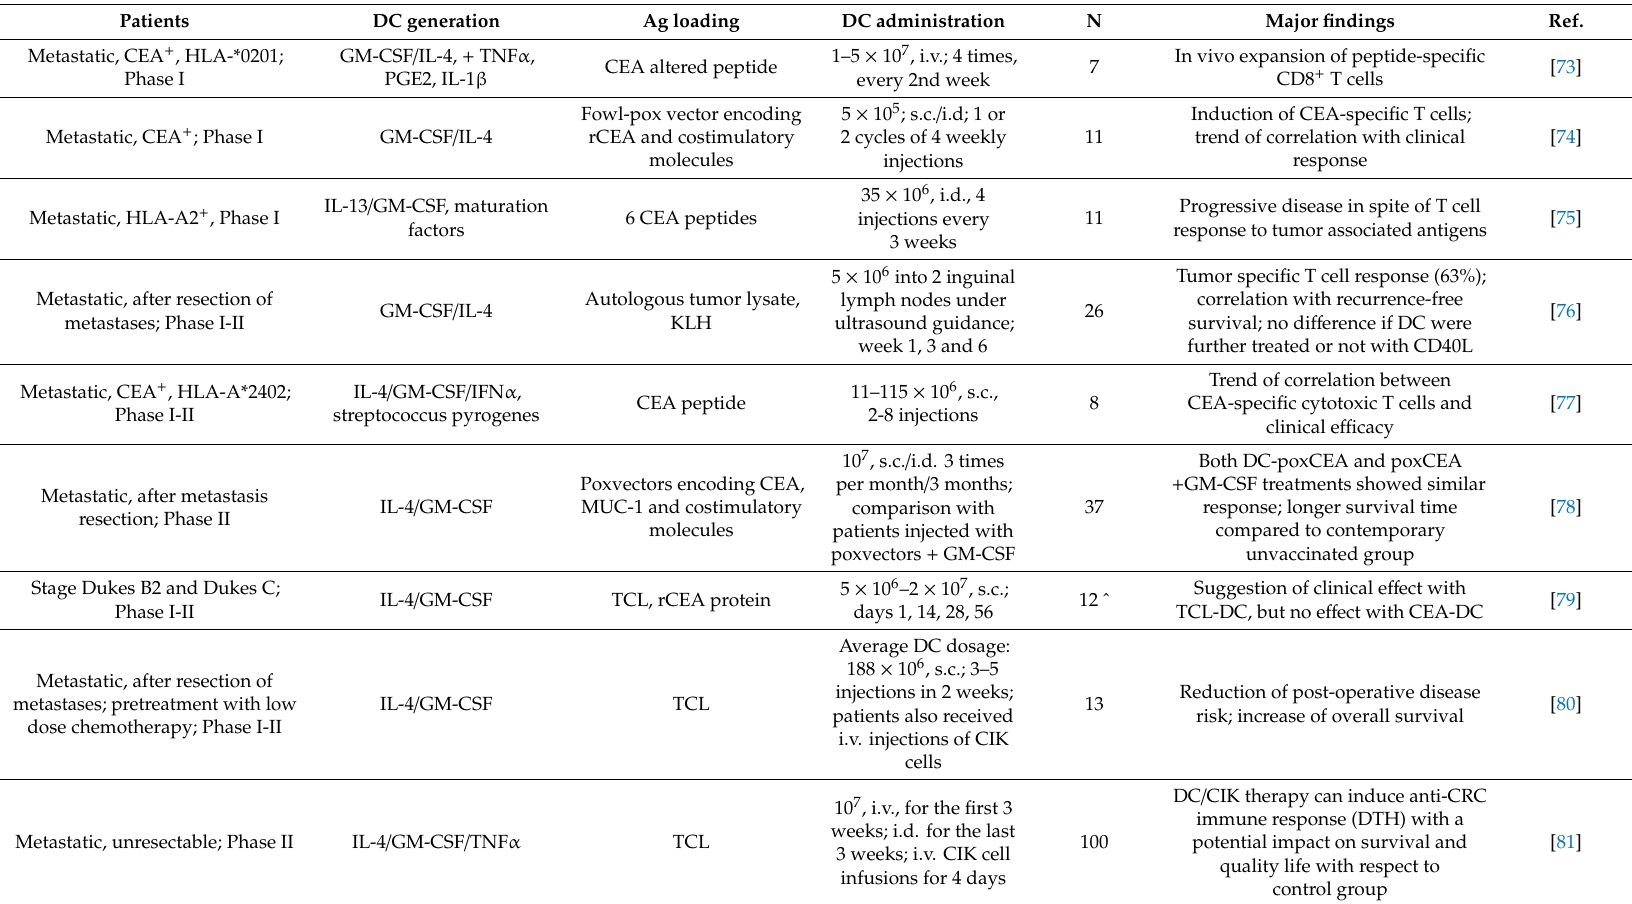
Table 1. Main clinical studies aimed at evaluating DC-based therapies in CRC